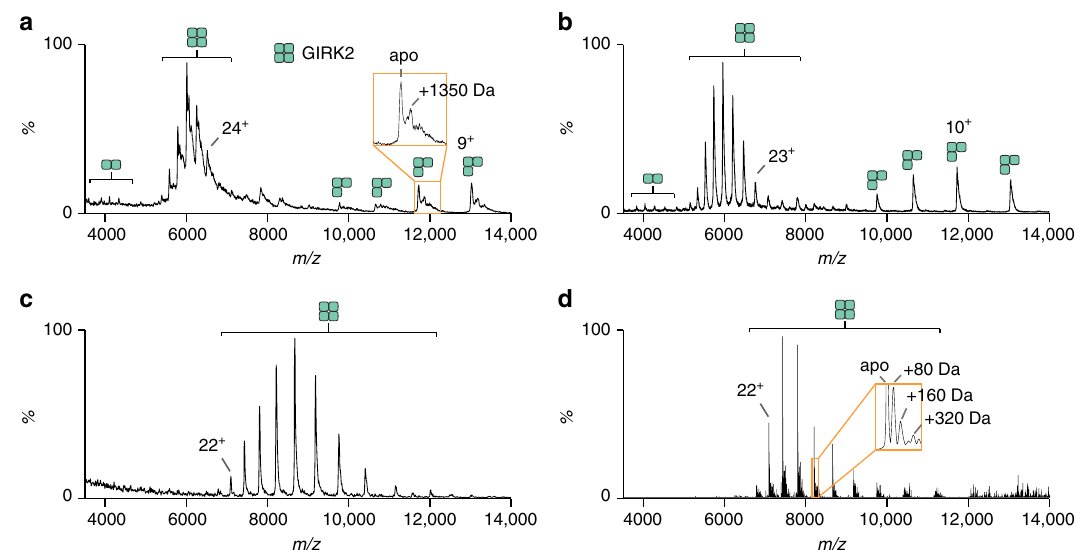
Fig. 1 Optimization of mouse GIRK2 for native mass spectrometry studies. a Initial preparation of GIRK2 in dodecylmaltoside (DDM) following established protocols for structural studies 25 . The mass spectrum was recorded using maximum energy settings to reveal 1350 Da adducts bound to GIRK2. b Mass spectrum of GIRK2 in DDM after DHPC treatment, which reveals a well-resolved mass spectrum with the lipid adducts removed. DHPC treated GIRK2 in the charge-reducing detergent, C 10 E 5 acquired under minimal energy regimes on a c Waters Synapt G1 and d Thermo Exactive plus EMR modi fi ed with a rear-entry source 49 . The mass spectra resolves small molecule adducts bound to the tetrameric